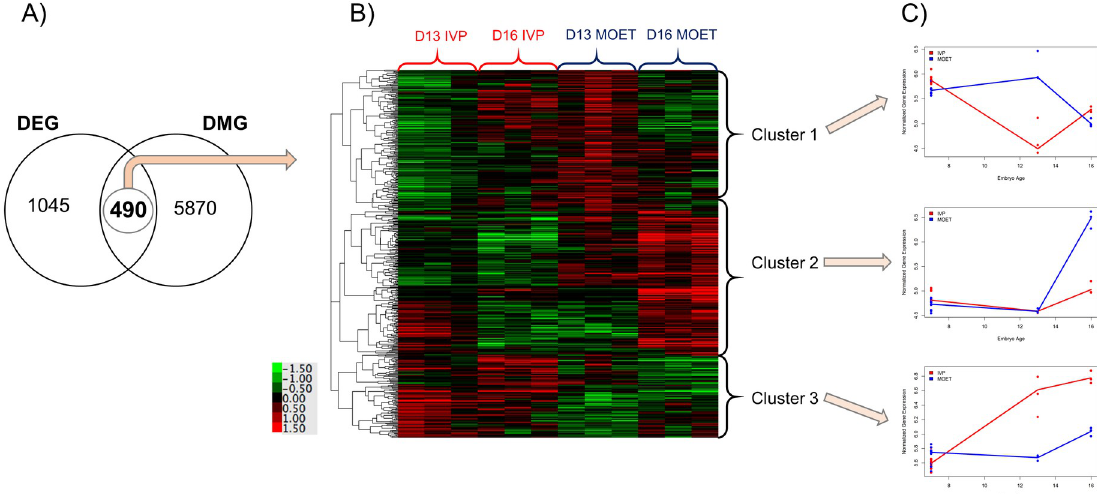
Fig 2. Identification of temporal genes both differentially expressed and differentially methylated between in vitro and in vivo produced embryos. A) Venn diagram showing the overlap between differentially expressed genes (DEG) and differentially methylated genes (DMG). DEG and DMG were defined as those genes or exonic regions changing differentially from blastocyst to elongation between in vivo and in vitro groups. B) Hierarchical clustering and heat map of the expressions of the 490 overlapped genes in day 13 (D13) and D16 embryos produced in vitro (IVP) or in vivo (after ovarian superovulation followed by embryo collection and transfer; MOET). C) Expression trajectories for genes in each of the main determined clusters, at 7, 13 and 16 days of embryo age, in IVP (red lines) or MOET (blue lines) groups.